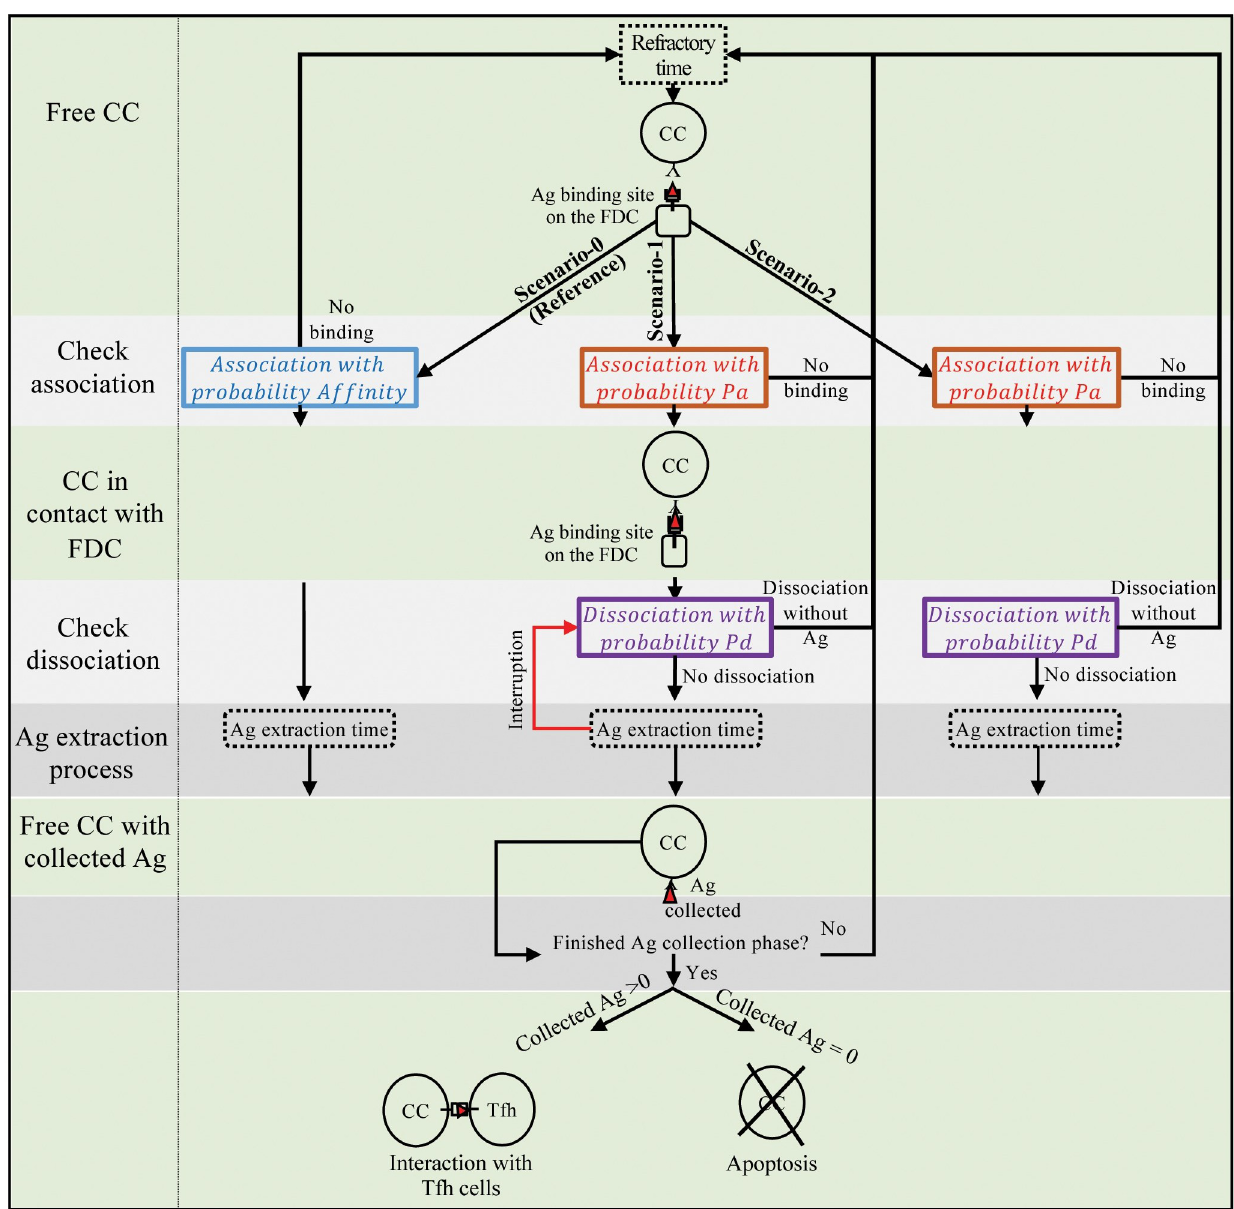
Fig 2. Schematic of Ag collection scenarios. Three mechanisms of Ag collection based on affinity and kinetic selection. The green rows denote the steps that the scenarios have in common. The starting point of each scenario is the event at which a free CC arrives at an Ag binding site. All scenarios end when the Ag collection phase is finished (last grey row), and the cell can engage in T-cell interactions. When no Ag is collected within 42 minutes, the CC will go into apoptosis. (A) Scenario-0: Competition for Ag depends on affinity directly. The CC’s probability of binding to Ag depends on the local Ag concentration (not shown in the figure) and CC’s affinity. After binding, the Ag extraction always starts directly. CC stays in bond until the Ag extraction process is finished after a period specified by a parameter ’Ag extraction time’ whereafter the CC captures the Ag. Subsequently, the CC may collect more Ag or engage in T-cell interactions. (B) Scenario-1: Competition for Ag collection depends on association (P a ) and dissociation (P d ) probabilities of CC that rely on the affinity. In this scenario, a CC associates to Ags presented on FDCs according to Ag concentration at the binding site and P a . In the next time step, the bond dissociates with a probability of dissociation (P d ) or otherwise, CC initiates the Ag extraction process. During the Ag extraction process, the bond between CC and Ag still can get disrupted probabilistically (red arrow) at each time-step (dt = 0.002 h) with probability Pd that may lead to disruption of Ag extraction before it is fully complete, in which case the CC dissociates without obtaining Ag. Subsequently, if the bond between CC and Ag does not dissociate due to interruptions during the Ag extraction, CC collects the Ag and re-engages in another interaction. (C) Scenario-2: Similar to Scenario-1, only there are no interruptions after initiation of Ag